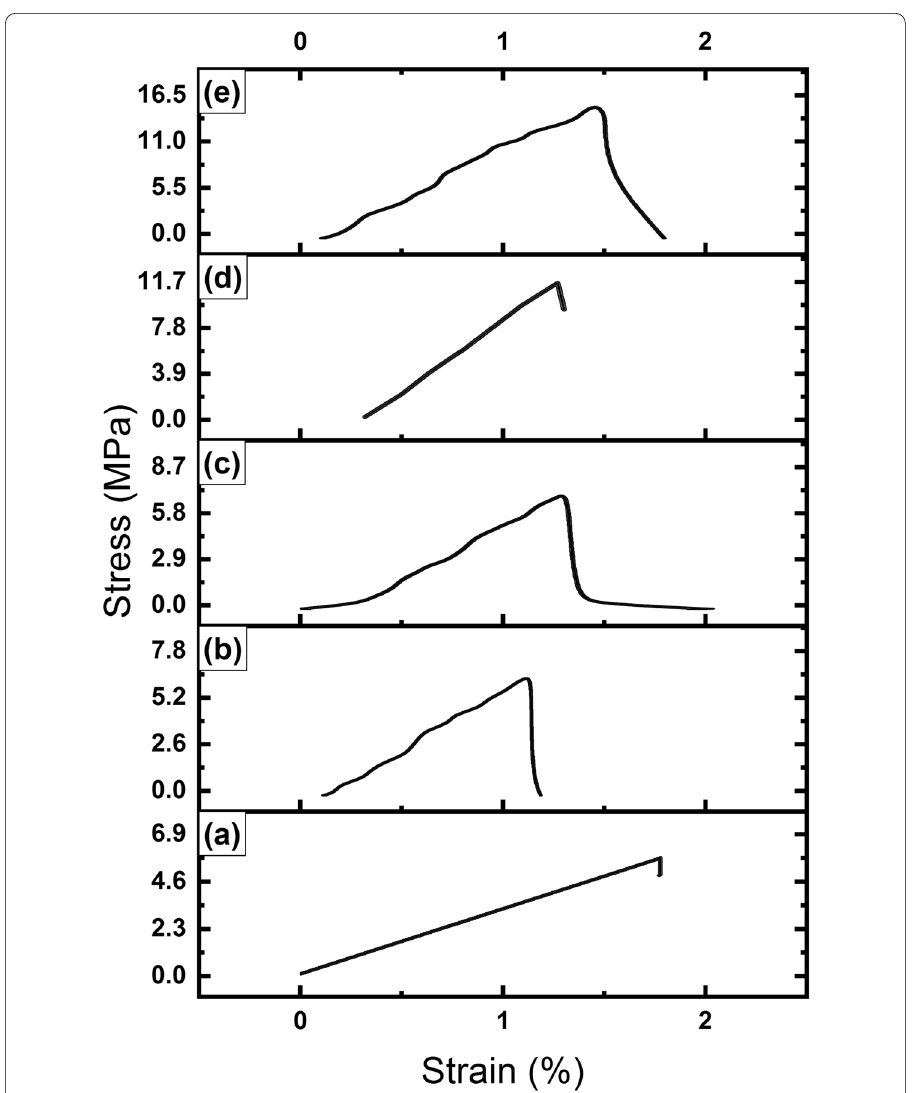
Fig. 5 Stress–strain curve for a TF-NC0, b TF-NC5, c TF-NC10, d TF-NC15, and e